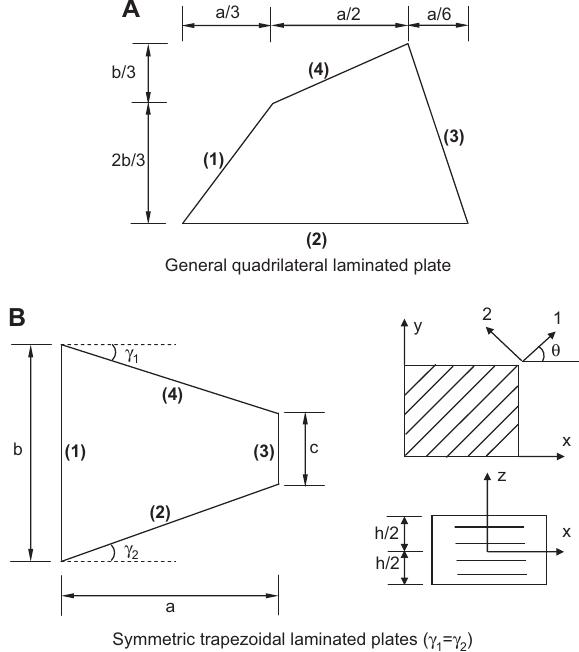
Figure 1 Laminated plates of (A) general quadrilateral planform and (B) symmetric trapezoidal